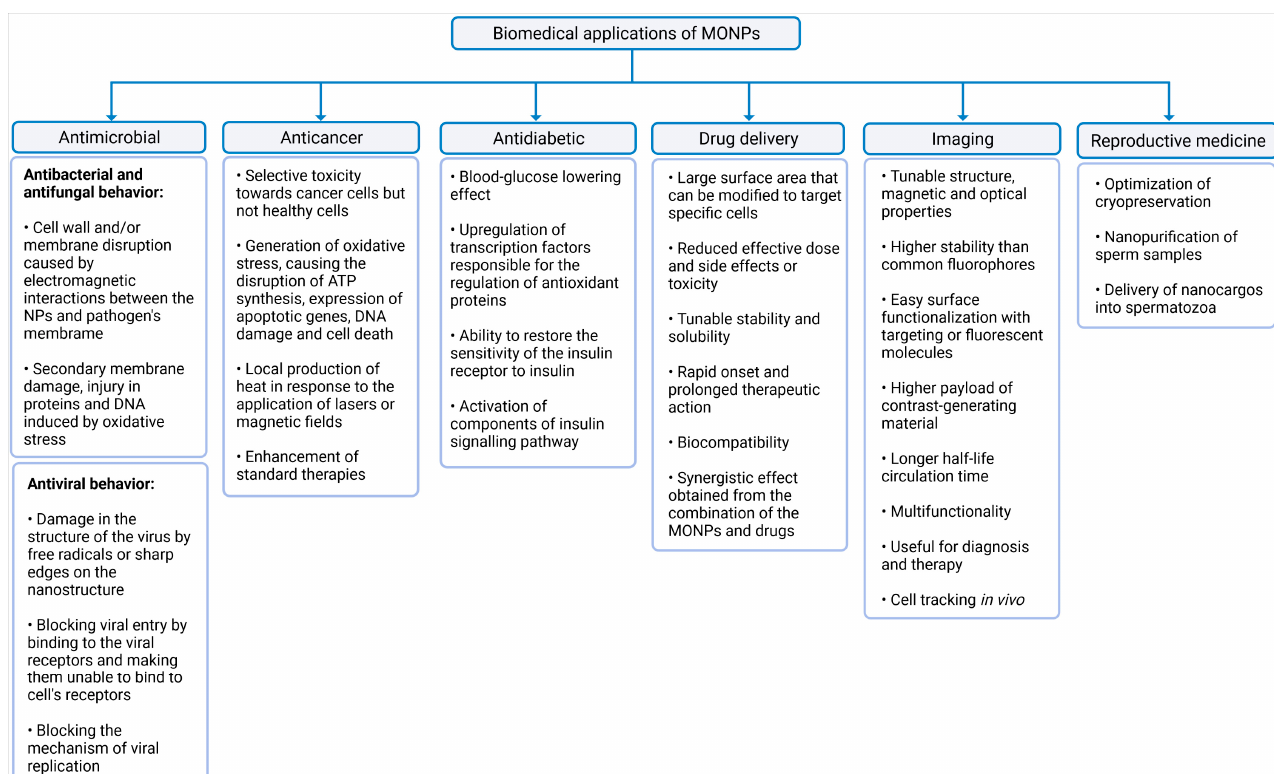
Figure 2. Summary of the biomedical applications of MONPs. The latter were divided into six categories, namely antimicrobial activity, anticancer activity, antidiabetic activity, drug delivery, imaging, and reproductive medicine, created with Biorender.com (accessed on 27 June 2021).